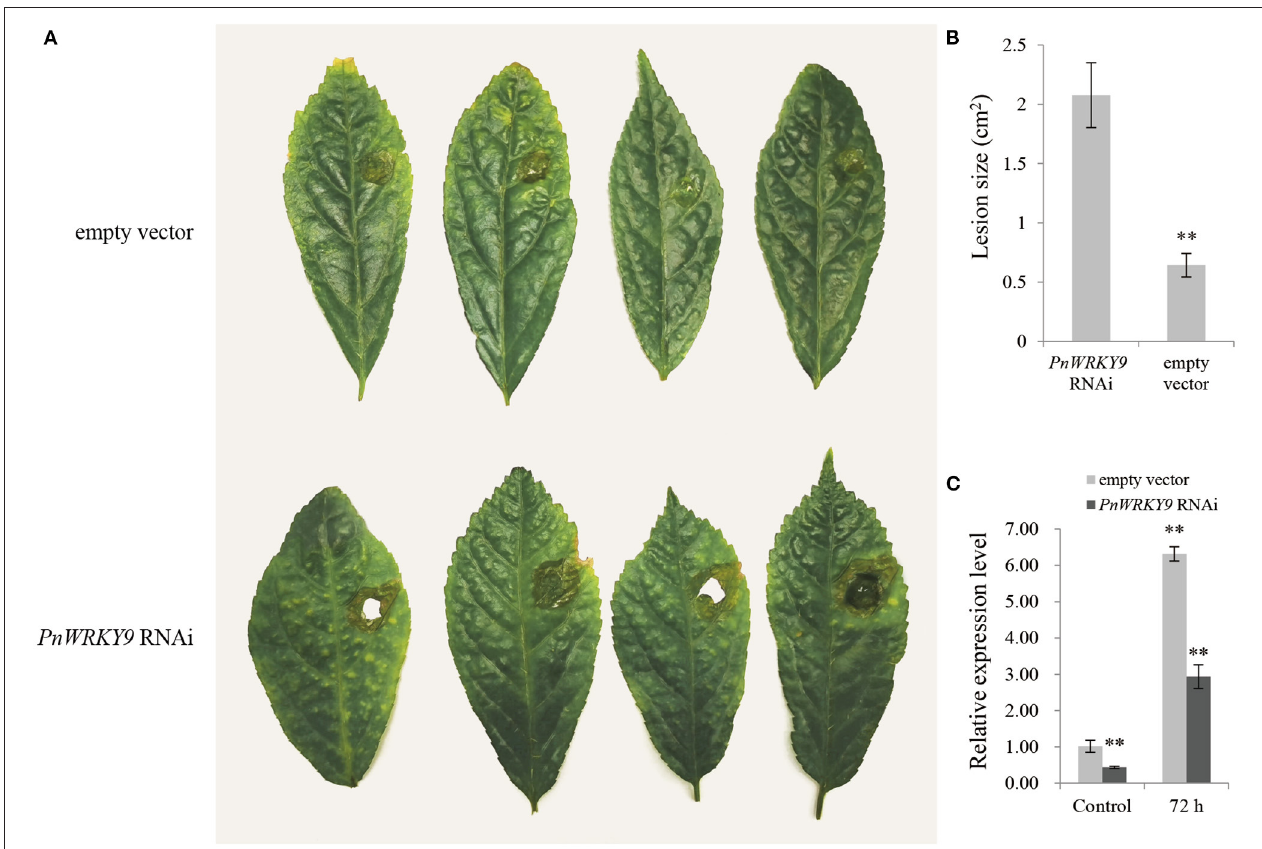
FIGURE 6 | The transiently expression analysis of PnWRKY9 RNAi vector in the leaves of P. notoginseng . (A) The symptoms of P. notoginseng leaves inoculated with F. solani , that were first infected with A. tumefaciens containing PnWRKY9 RNAi vector. The P. notoginseng leaves with expressed empty RNAi vector and inoculated F. solani was as control. (B) The lesion size in P. notoginseng leaves expressing the PnWRKY9 RNAi vector and empty RNAi vector, respectively (** p < 0.01). (C) The PnWRKY9 expression levels in P. notoginseng leaves expressing PnWRKY9 RNAi vector and empty RNAi vector, respectively. The results were calculated by the 2 − 11 Ct method and analyzed by the t test (** p <